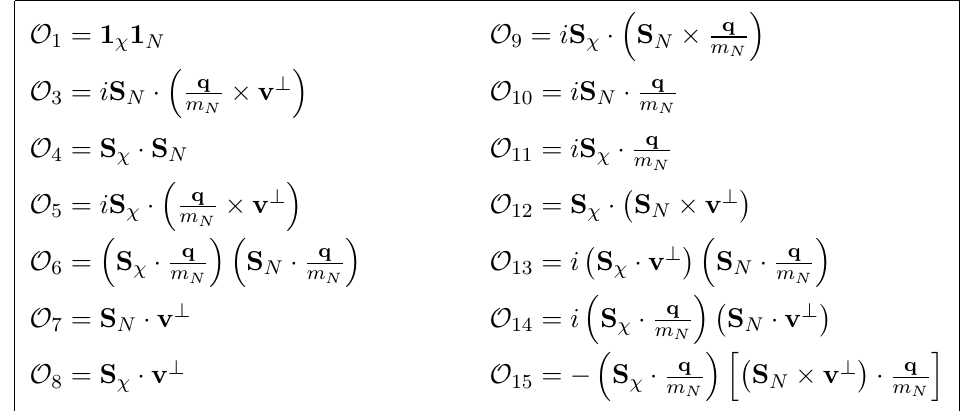
Table 1 . Non-relativistic quantum mechanical operators de(cid:12)ning the general e(cid:11)ective theory of one-body DM-nucleon interactions. Taken from ref.